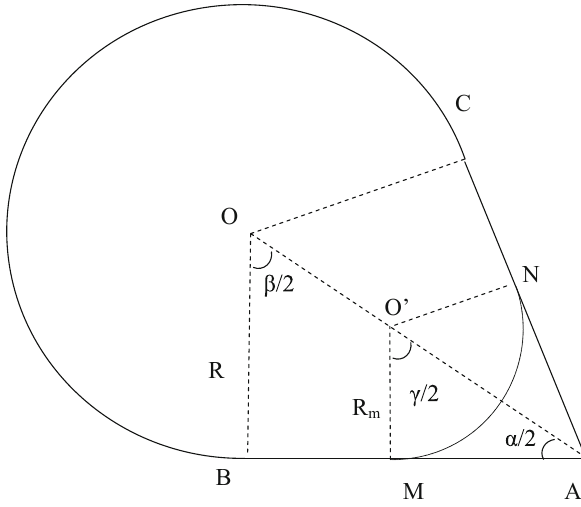
Fig. 2 Cross section of the single-corner capillary tube in the case of complete wetting. The points O and O’ are the center of the circle portion of the cross section and the center of the meniscus,